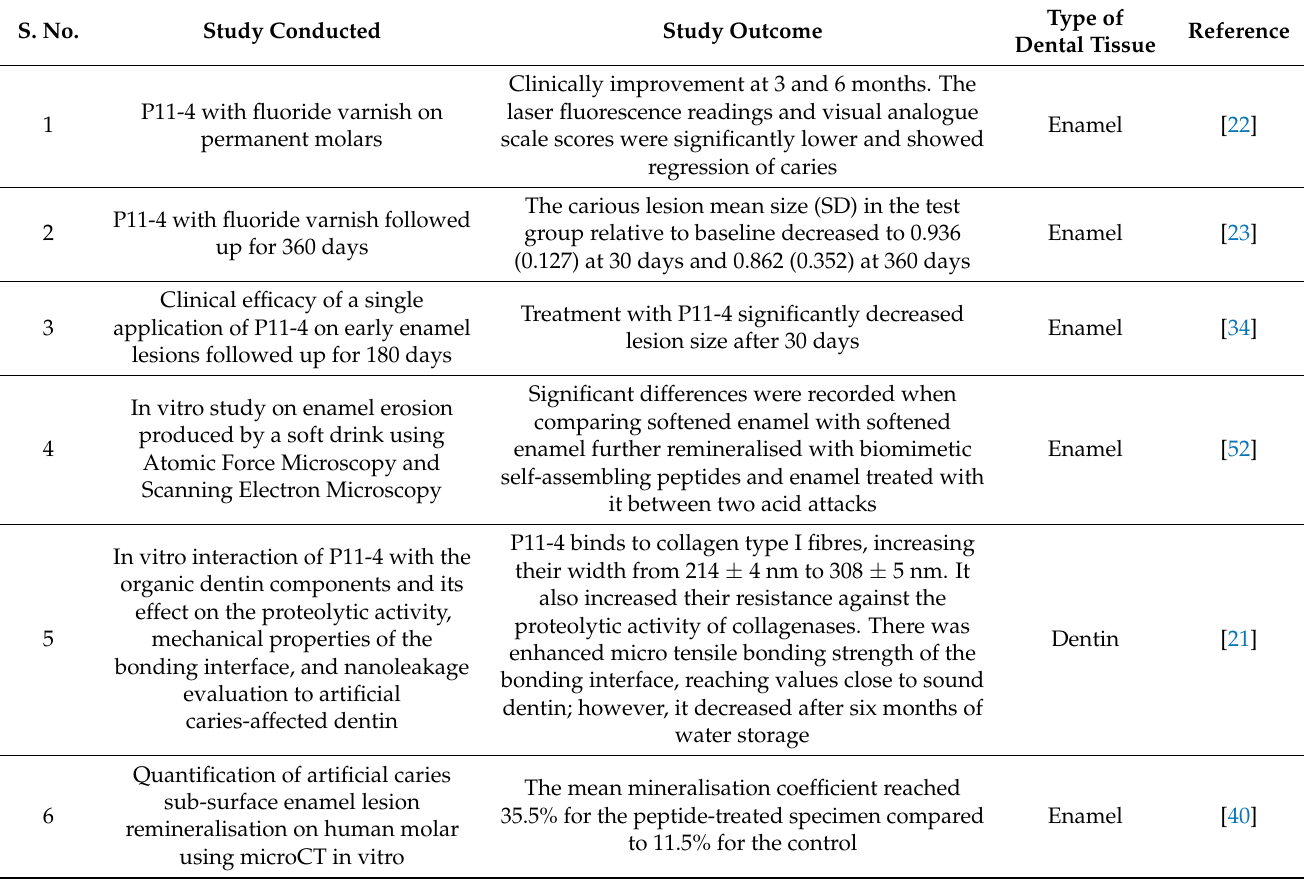
Table 1. Functions of Self-assembling Peptide